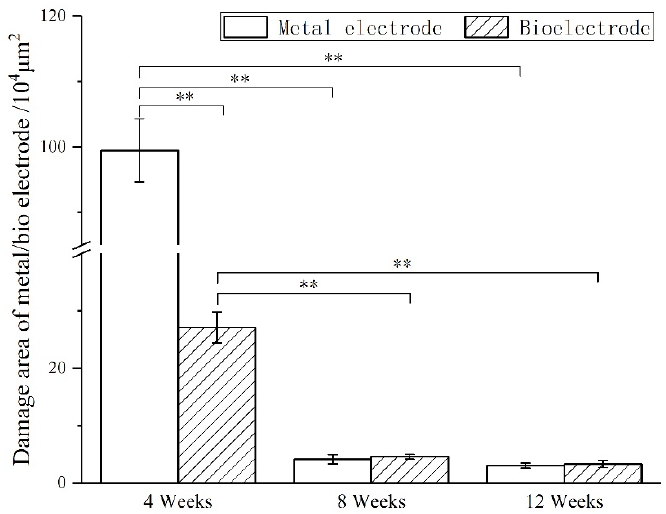
Figure 8. Damage area of metal/bio electrodes at different times.(** p < 0.01).